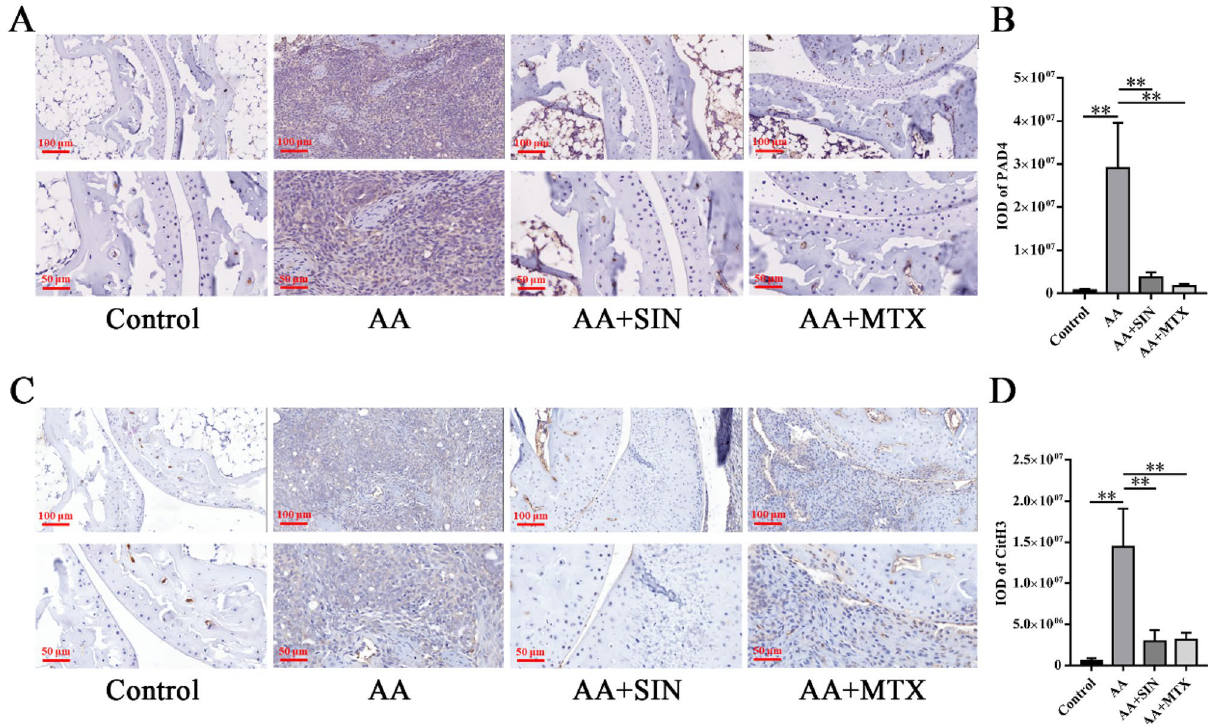
Figure 6. Sinomenine inhibited the formation of NETs in vivo. ( A ) IHC staining was used to determine the level of PAD4 in ankle joint sections from mice. Representative images are shown. ( B ) The IOD of PAD4 in ( A ). The data are shown as the mean ± SD (n = 3). ( C ) IHC staining was used to determine the level of CitH3 in the ankle joint sections from the mice in each group. Representative images are shown. ( D ) The IOD of CitH3 in (C). The data are expressed as the mean ± SD (n = 3). *p < 0.05 , **p < 0.01 . “n = 3” represents three mice with representative joint diameters and arthritis scores that were selected from each group to prepare ankle joint tissue sections, and one representative picture of each mouse was used for